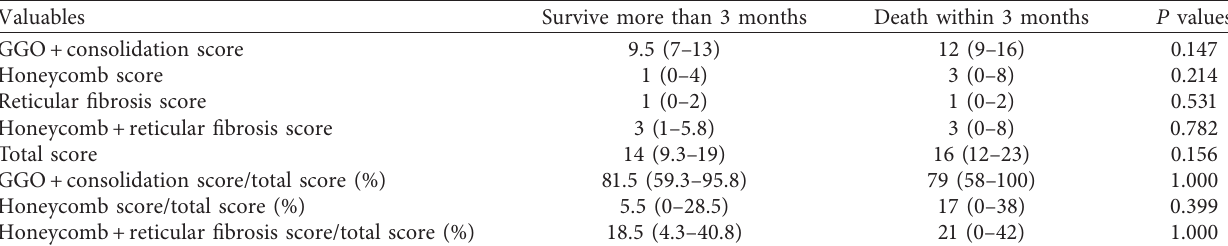
Table 2: HRCT scores at diagnosis of AE.